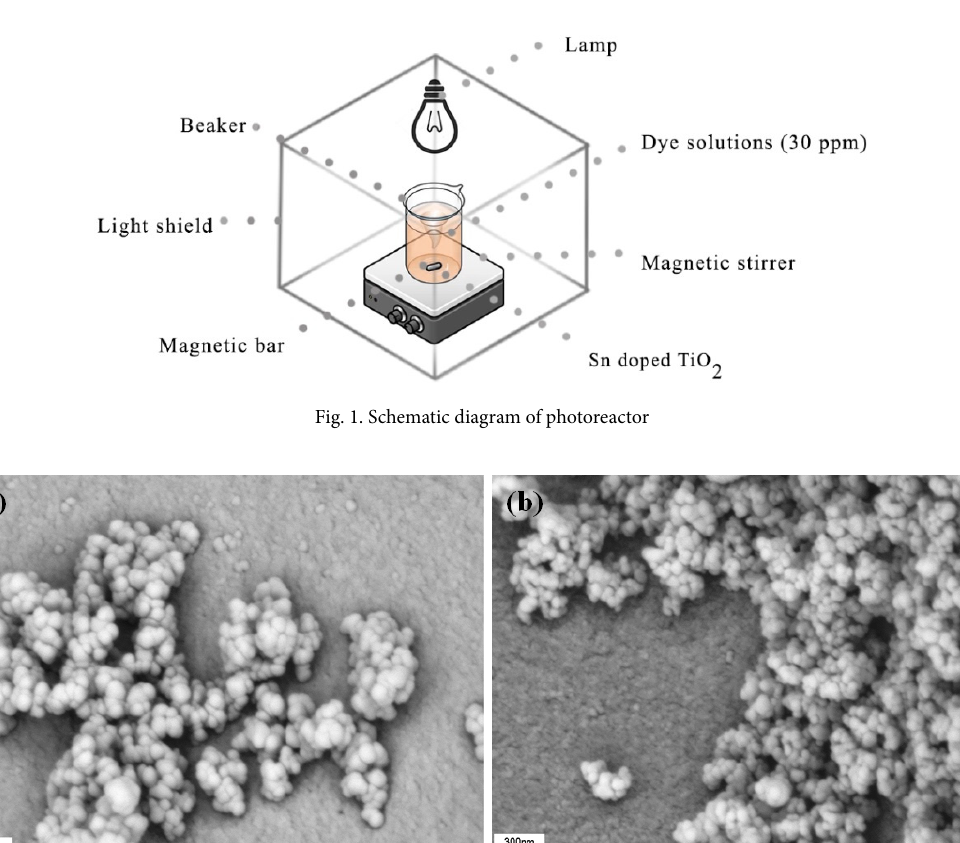
nanoparticles and b) sample 2